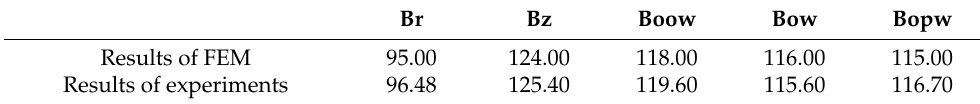
Table 3. Ultimate load received using FEM analysis and experiments